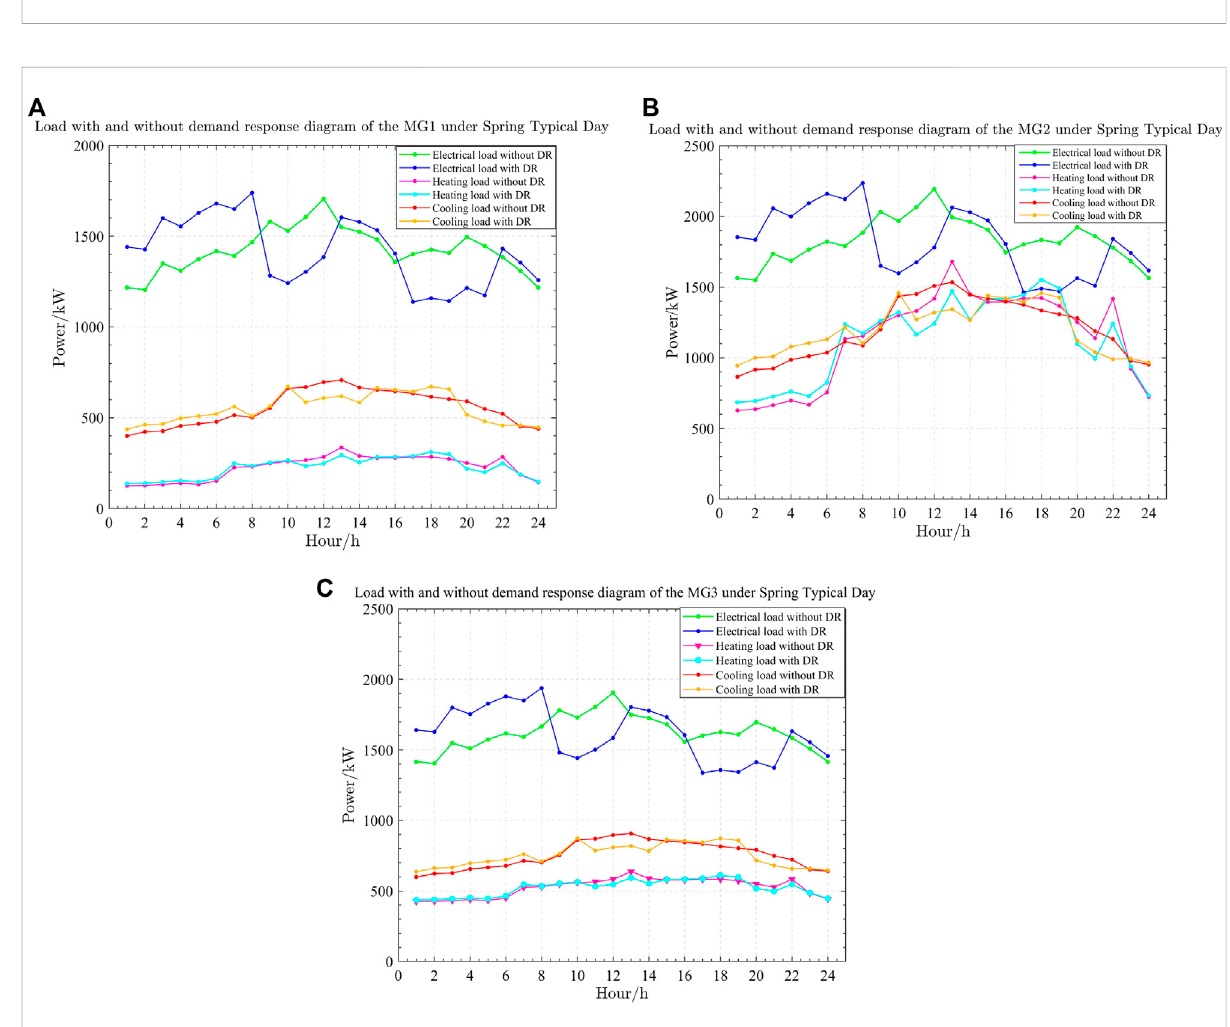
FIGURE 8 Comparison of the electrical loads under Spring Typical Day between scenarios 3 and 4: (A) MG1, (B) MG2, and (C)